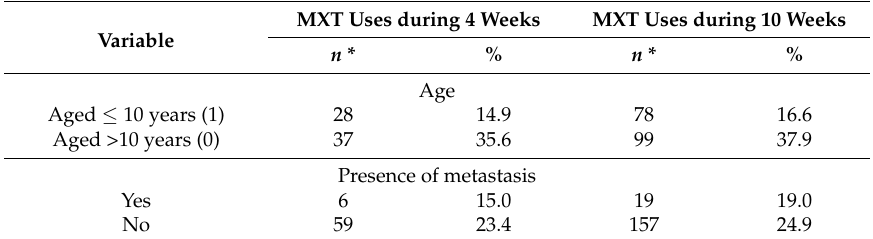
Table 5. Rate* of Methotrexate uses according to age strata and presence of metastasis with severe